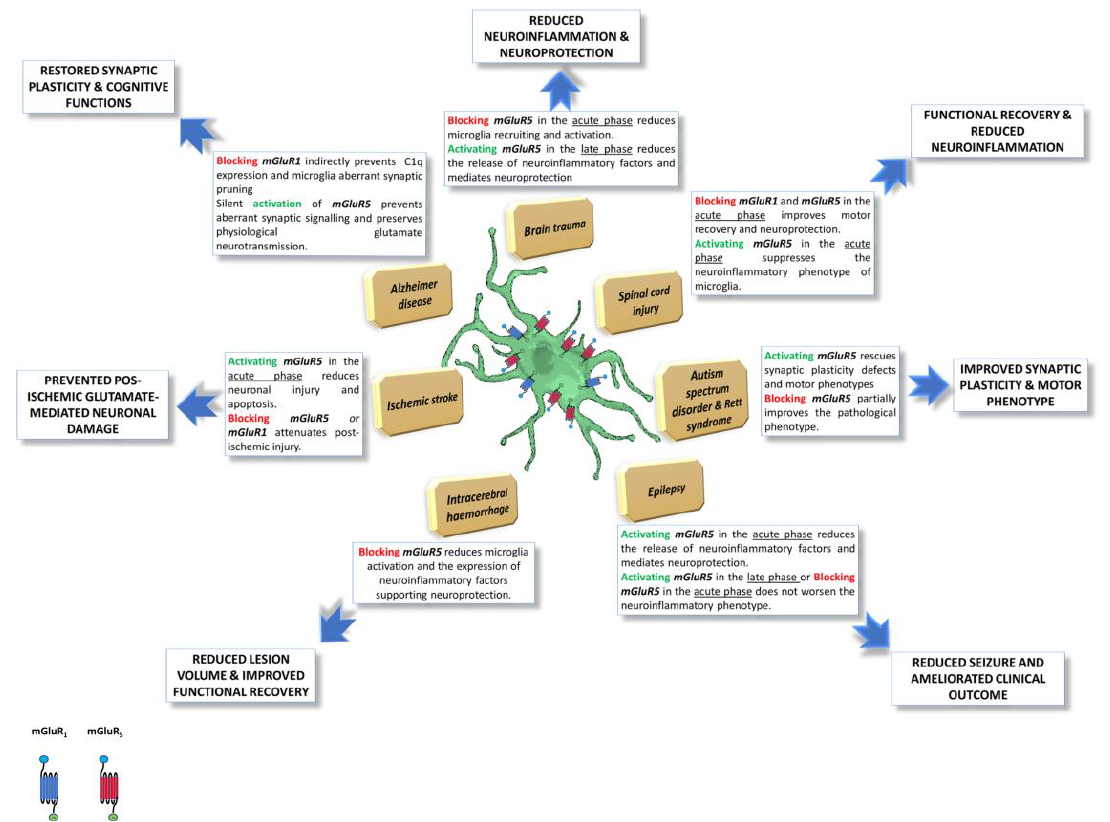
Figure 1. Schematic representation of microglia-expressed group I mGluRs effects, in different pathological conditions. Group I mGluRs are key regulators in different pathological conditions, directly or indirectly influencing the microglia cell activation state. Pharmacological or genetic modulation of Group I mGluRs, also expressed by microglia cells, can affect the disease course, with often dual or biphasic effects, depending on the time window of intervention and duration of the treatment, overall being a promising tool to develop new pharmacological drugs. The figure was partly generated using Servier Medical Art, provided by Servier, licensed under a Creative Commons Attribution 3.0 unreported license “ https://creativecommons.org/licenses/by/3.0/ (accessed on 19 January 2023) ”.